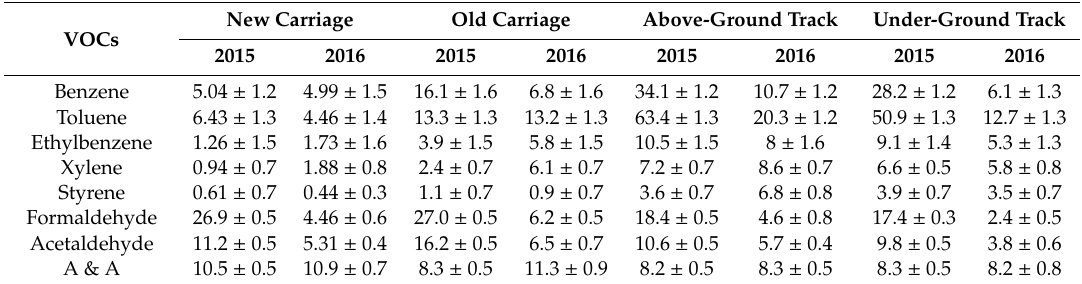
Table 2. The concentration of Volatile organic compounds (VOCs) in metro carriage under di ff erent conditions (Mean ± S.E.).